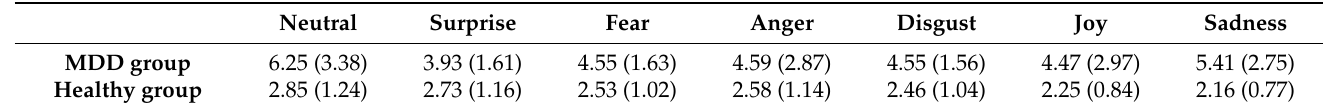
Table 3. Average reaction time and standard deviation (in seconds) per emotion for the depression and healthy